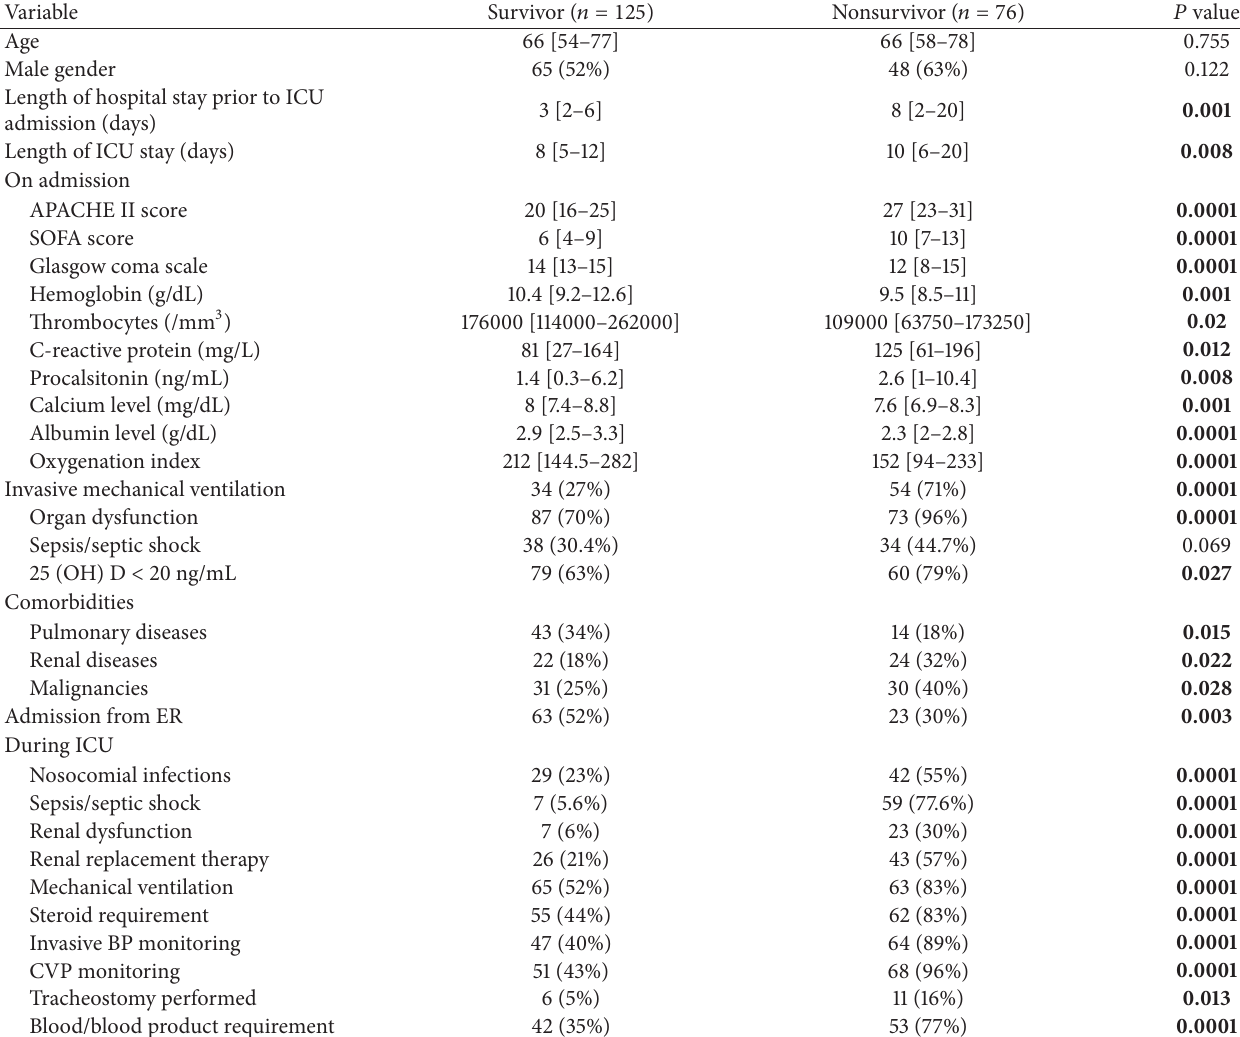
Table 4: Characteristics of patients who survived (survivor) or died (nonsurvivor) in ICU.